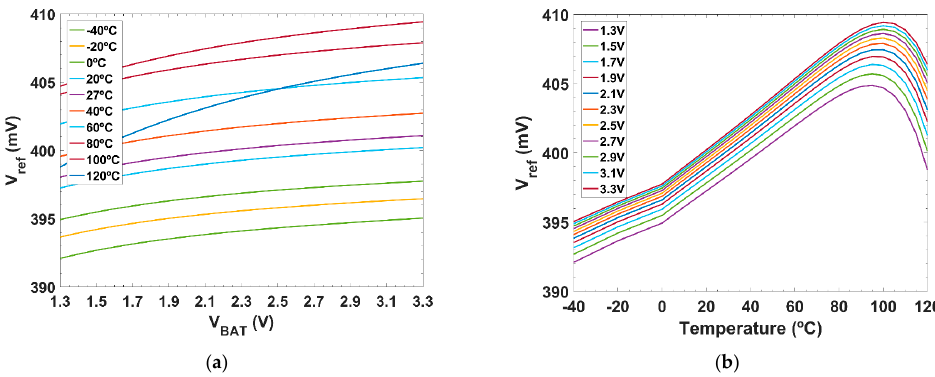
Figure 10. Reference voltage, V ref , dependence with: ( a ) temperature and ( b ) battery voltage.